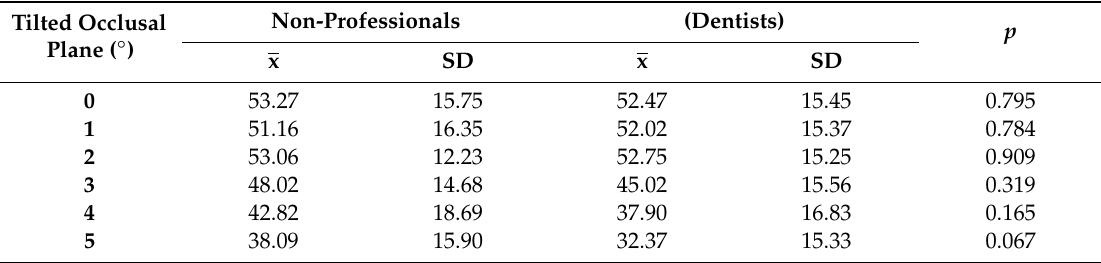
Table 4. Perceptions of dentists and non-professionals towards increment level of tilted occlusal plane. Non-Professionals (Dentists) p Tilted Occlusal Plane ( ◦ ) x SD x